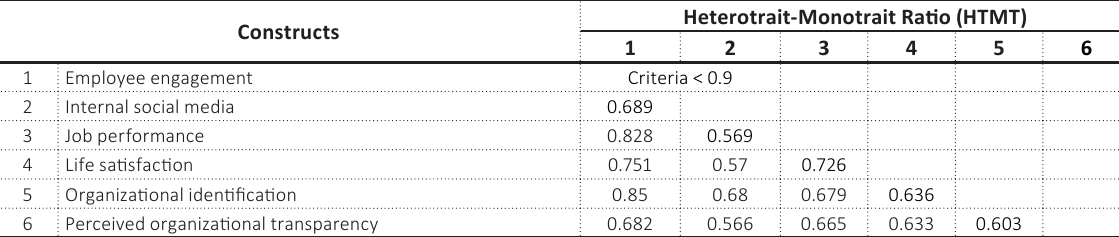
Table 2. Discriminant validity (Heterotrait-Monotrait ratios)